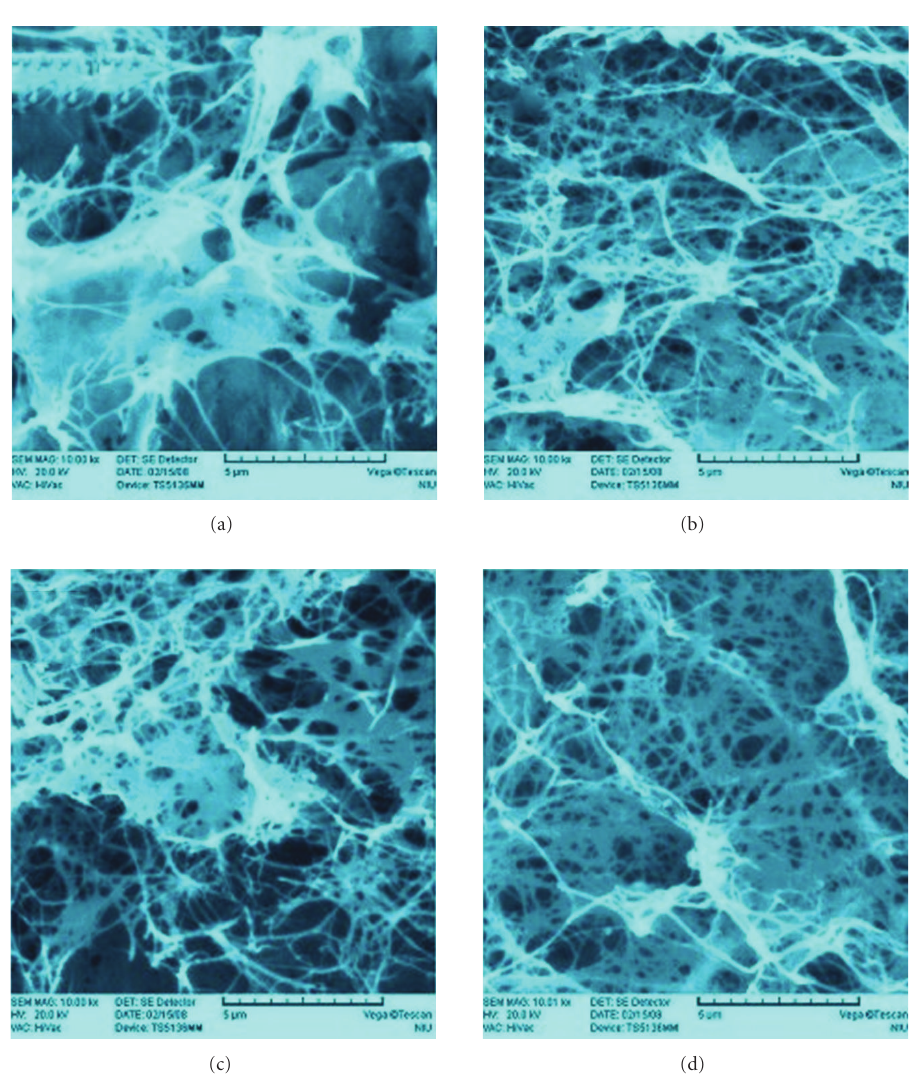
Figure 23: SEM photographs (10000X) of LG/NC (a) Gelatin/NC (b) EMG/NC (c) NPEMG/NC (d) PEMG/NC